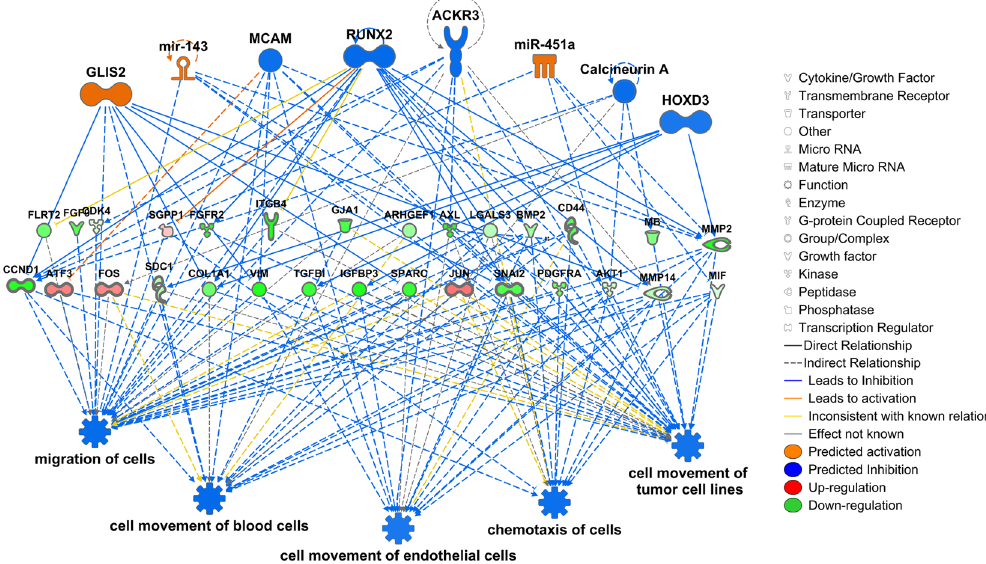
Figure 3. Upstream regulator effect analysis of chemotaxis and cell migration pathways using Ingenuity Pathway Analysis. Pathways that are known to influence movement of blood and tumour cells are down regulated in type III cells relative to Tas1r3 + cells; these functions likely influence movement of Tas1r3 + taste cells. The top tier in each network shows master regulators, the middle tiers show the intermediate regulators in the data set through which the master regulators exert their effect on the regulated functions, which are shown in the bottom tier. The predicted state of the regulators and affected functions are colour coded, with orange colour indicating activation and blue indicating inhibition. Up-regulated molecules in the middle tiers are colour coded red and down-regulated molecules in green, with the intensity matching the false discovery rate calculated by DESeq. 2. The shape of each molecule indicates its molecular function. The causal relationships that are consistent with Ingenuity Pathway Analysis database are represented with orange and blue lines, while the inconsistent relationships are indicated with yellow lines.